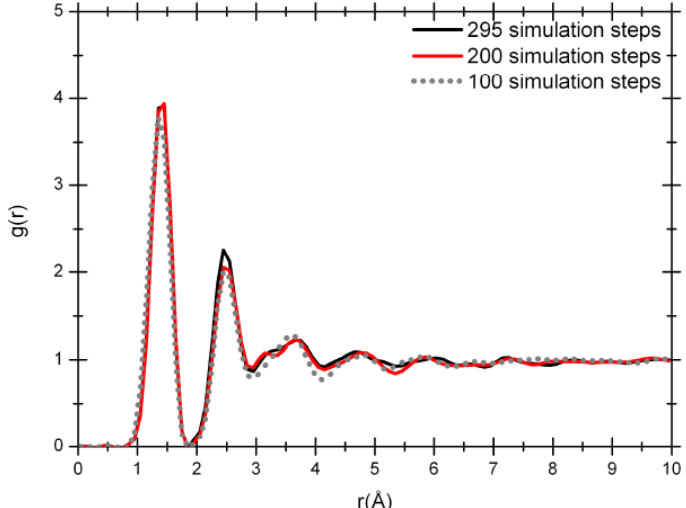
Figure 5. RDFs for 61.1% porosity nanoporous carbon with a density of 1.38 g/cm 3 . The dotted line is the RDF for 100 simulation steps; the dark gray solid line (red for the online version) is the RDF for 200 simulation steps and the black solid line is the RDF for 295 simulation